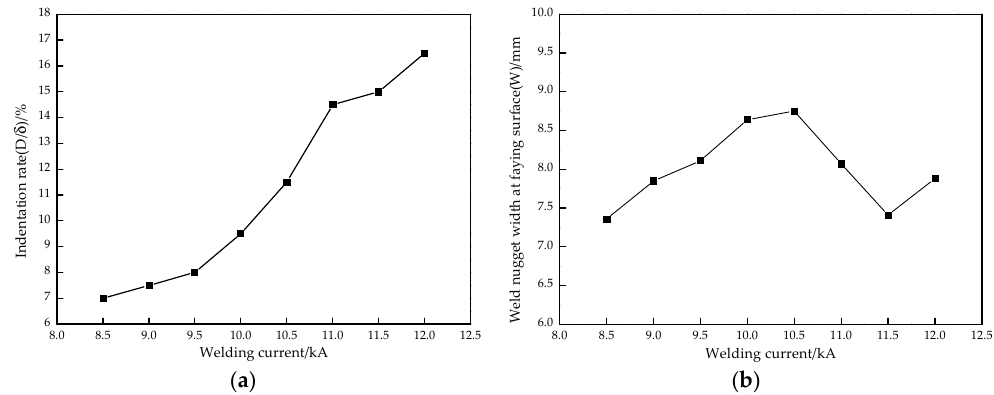
Figure 8. Relationships between the welding current and ( a ) indentation rate (D/ δ ); ( b ) weld nugget width at overlap surface (W).